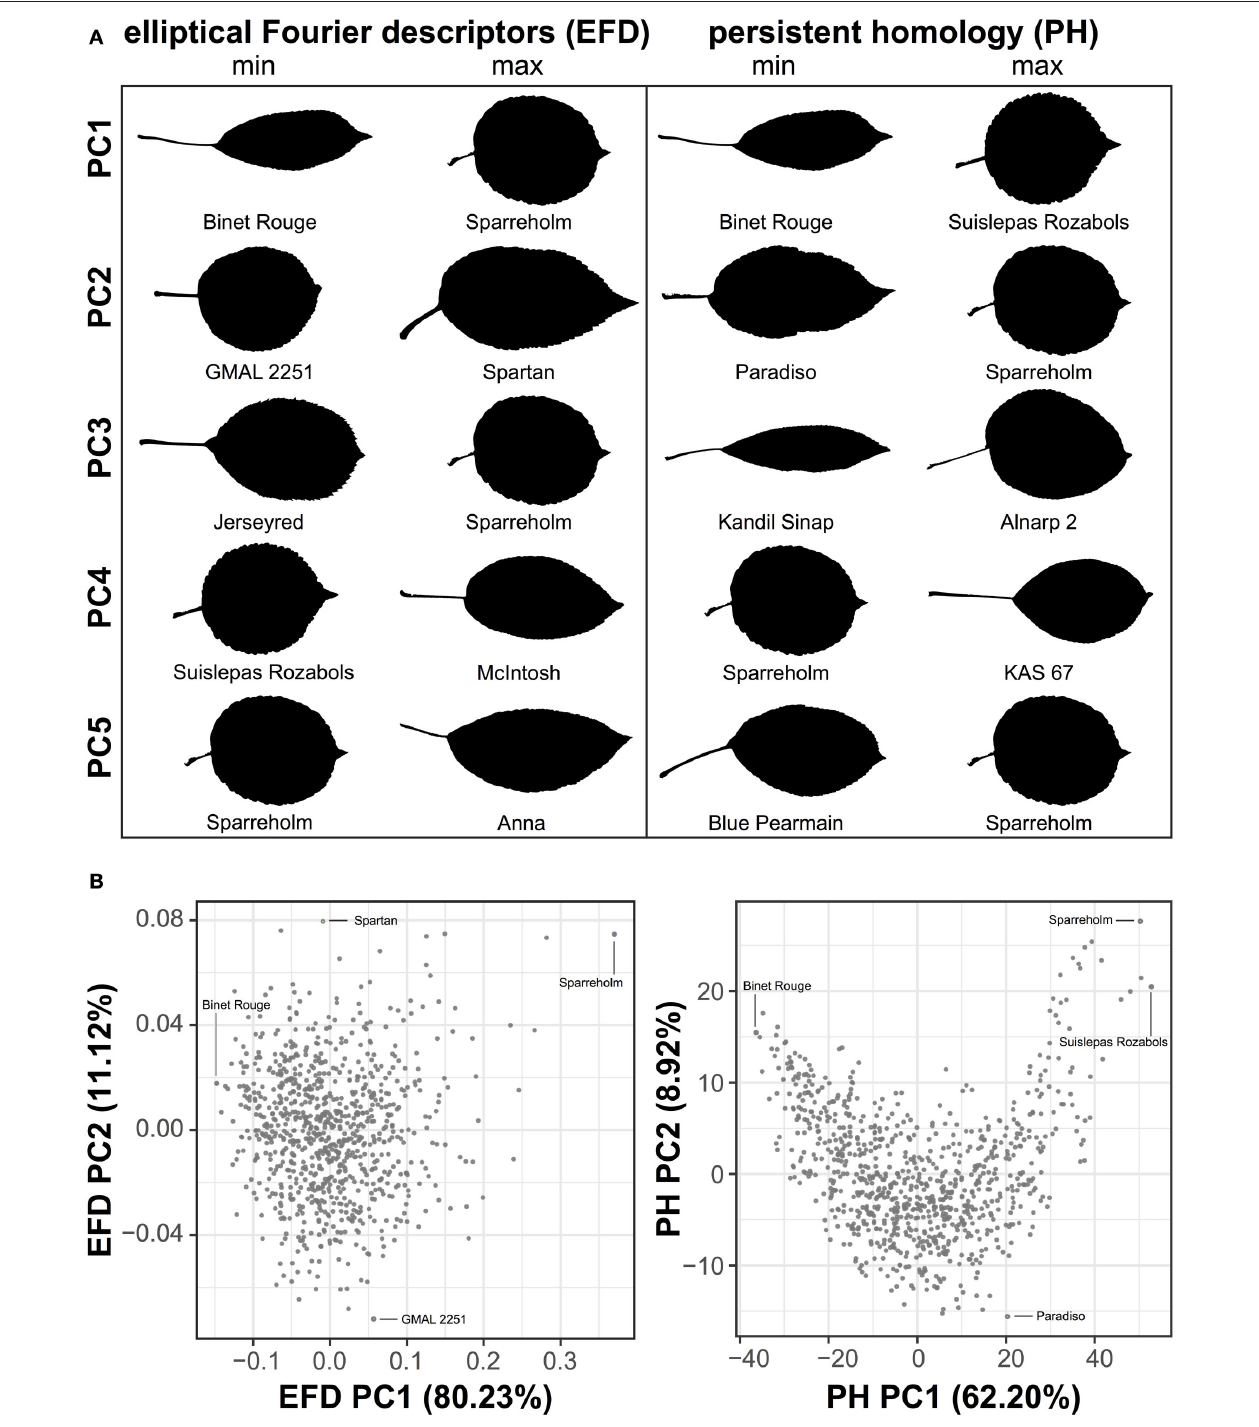
FIGURE 3 | Examples of leaf shape across PCs derived from EFDs and PH. Binary images of leaves from accessions with minimum and maximum values along PCs 1–5 for EFD and PH estimates. PCs were calculated using averages estimated across 8–10 leaves but only a single representative leaf is displayed. PCs were REML-adjusted based on tree position in the orchard. The accession name is also listed (A) . Visualization of PC1 vs. PC2 for EFD and PH data. Accessions with minimum and maximum values along PC1 and PC2 are indicated (B) .